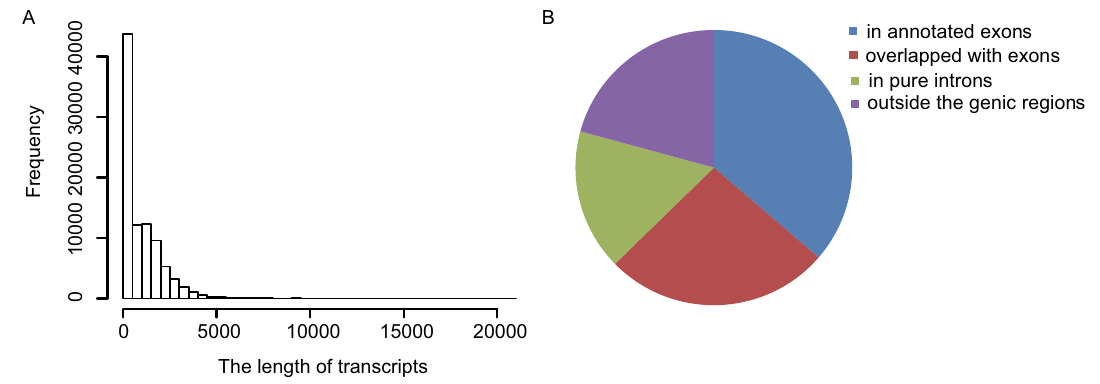
Figure 2. Summary of the assembled transcribed fragments. ( A ) Length distribution of the assembled transcribed fragments. ( B ) Classification of the assembled transcribed fragments. The transcribed fragments overlapping with annotated exons, exons, introns and non-gene regions are shown in blue, green, red and purple, respectively. This figure was created in Microsoft Excel 2013 and Adobe Illustrator